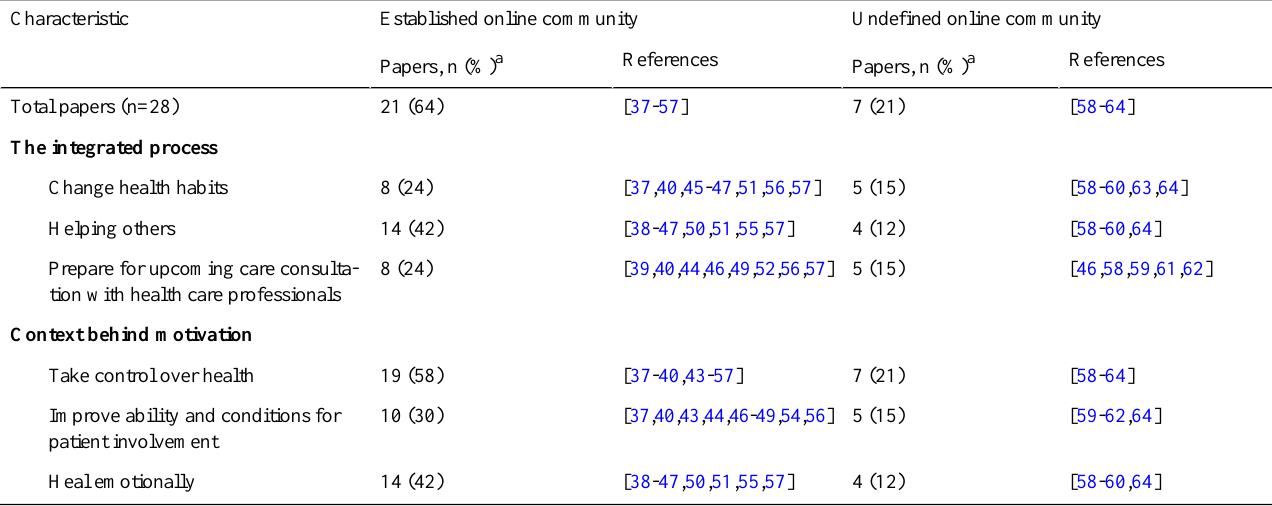
Table 3. The integrated processes and context of motivation in established and undefined community papers (N=28/33).